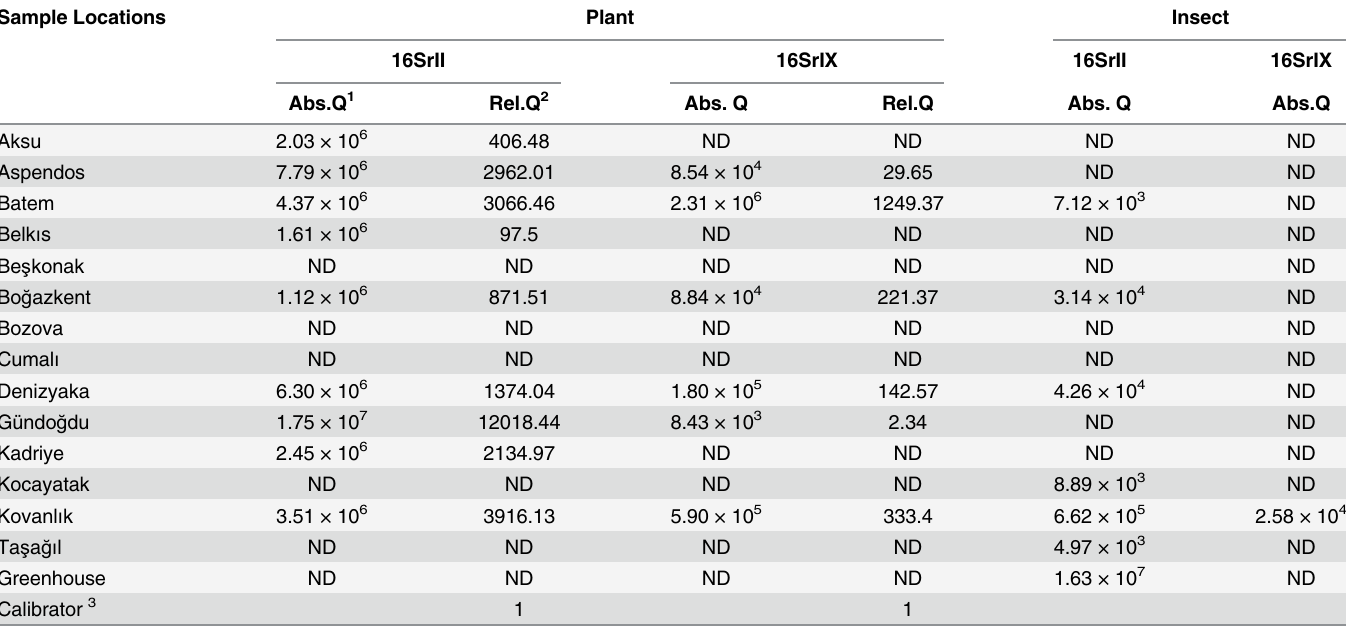
Table 4. Absolute and relative quantities of 16SrII and 16SrIX group phytoplasmas determined by qPCR in plant and insect samples tested in this study. Sample Locations